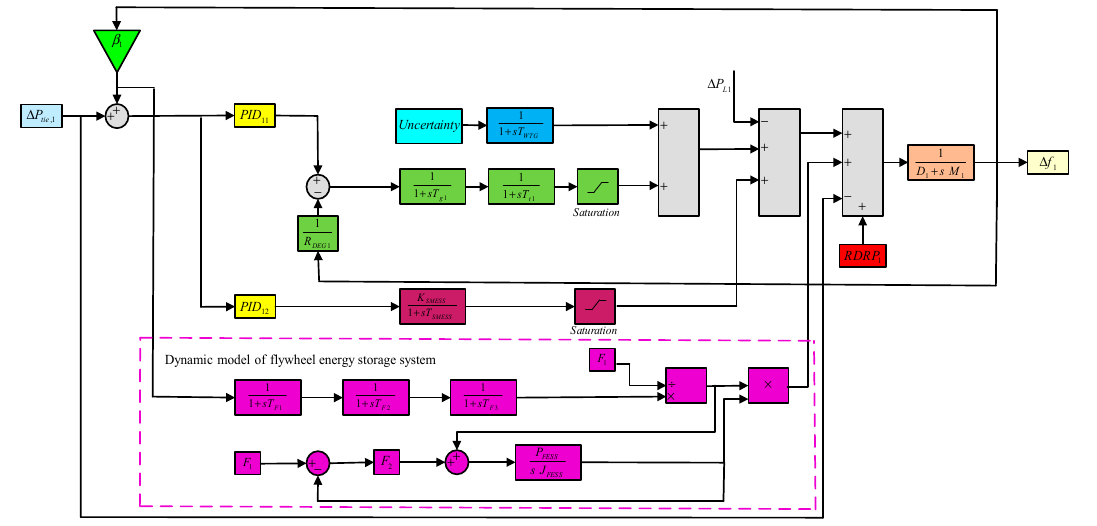
Figure 2. Dynamic model of microgrid 1. PID: Proportional integral derivative, RDRP: Regional demand response program.